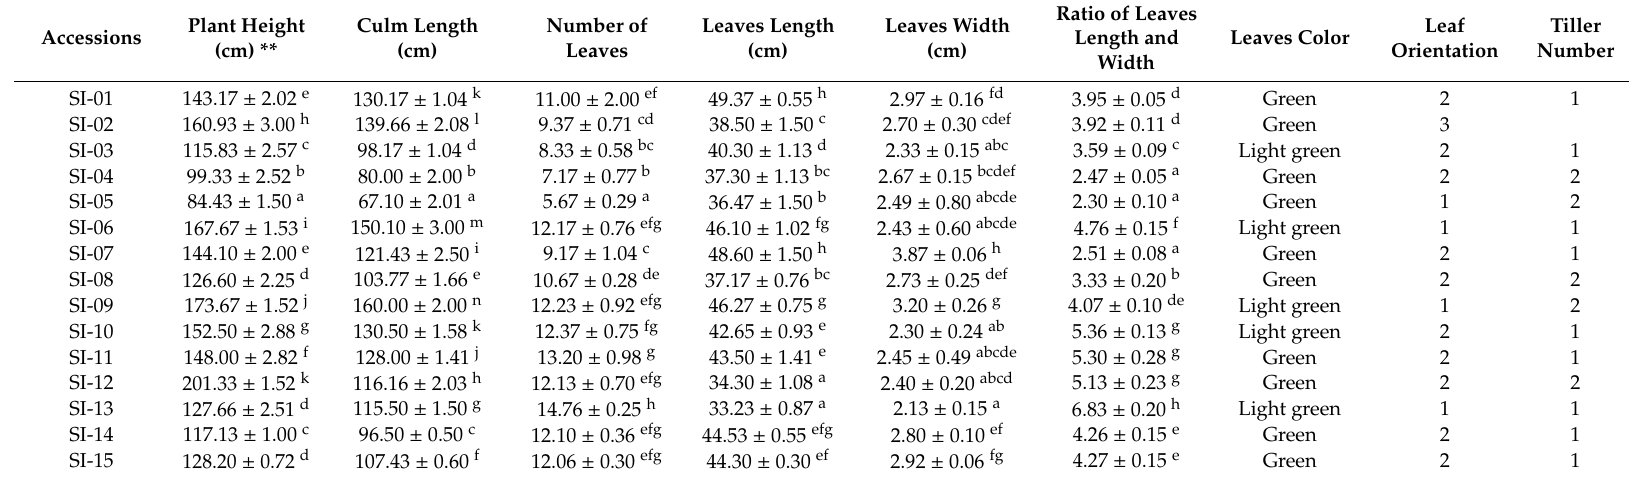
Table 2. Morphological characteristics of the selected accessions of S. italica